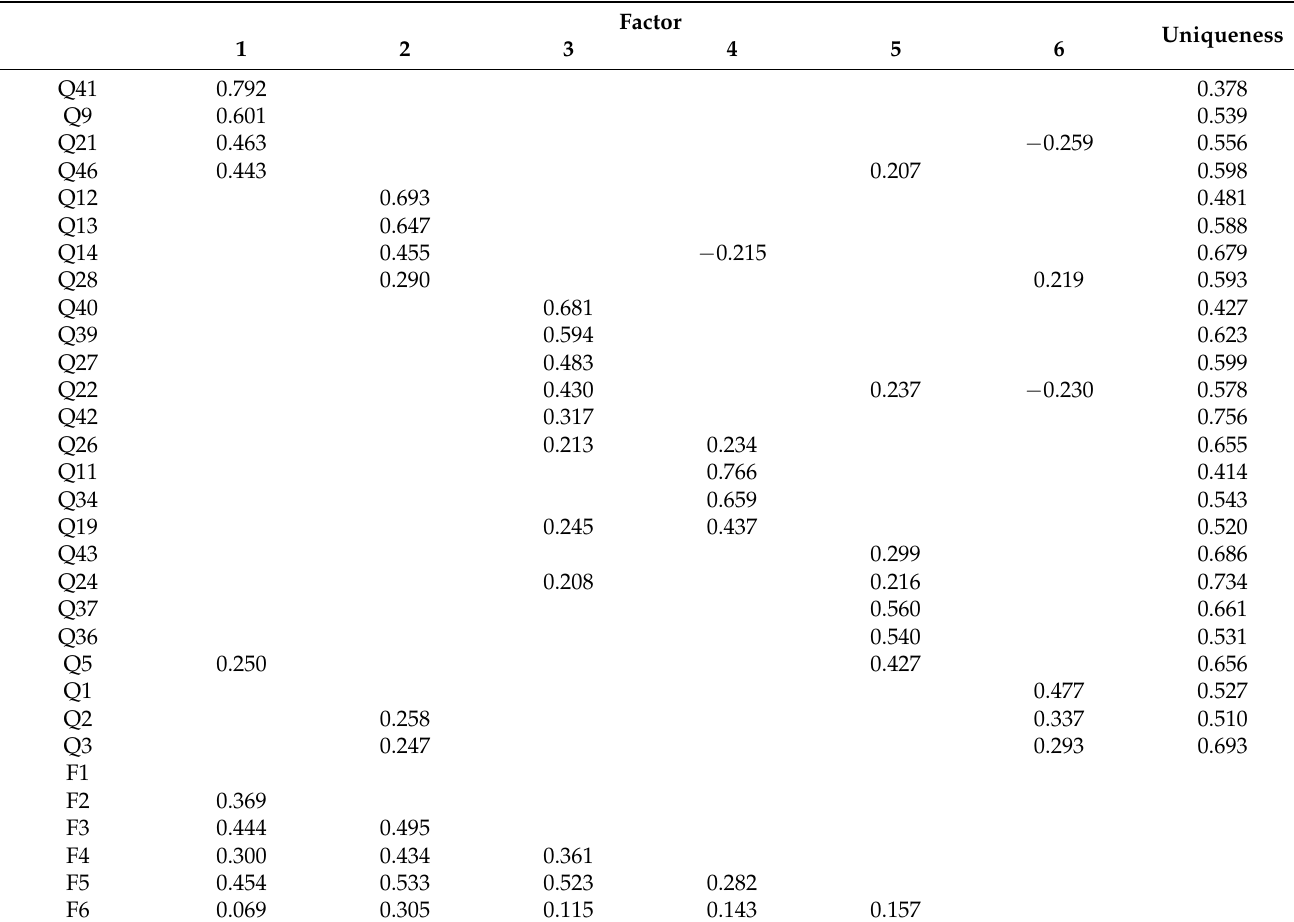
Table 3. Factor loadings and inter correlations.